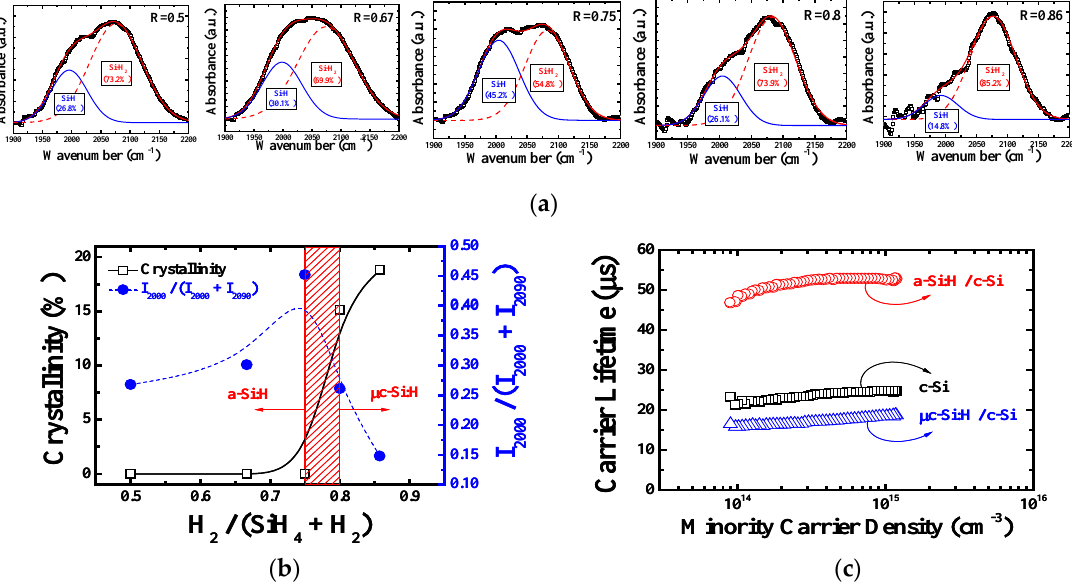
Figure 2. ( a ) The Fourier transform infrared (FT-IR) spectroscopy characteristics as a function of GR ( b ) The calculated crystallinity by Raman spectroscopy and microstructure by FT-IR ( c ) Carrier lifetime characteristics of the passivation layers formed using different passivation layers by QSSPC.